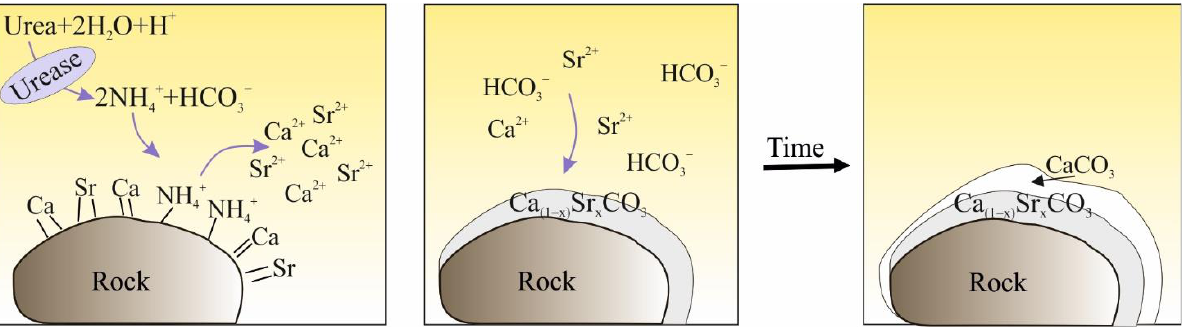
Figure 2. An outline of the precipitation of carbonate coatings [57].